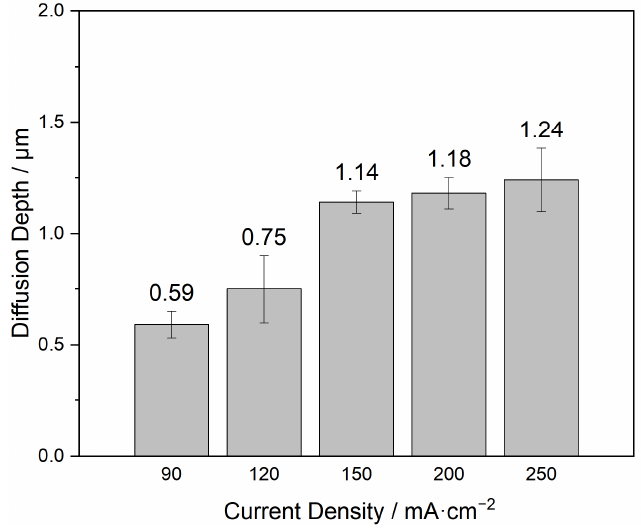
Figure 7. Thickness of the vanadium deposition layer at different current densities.